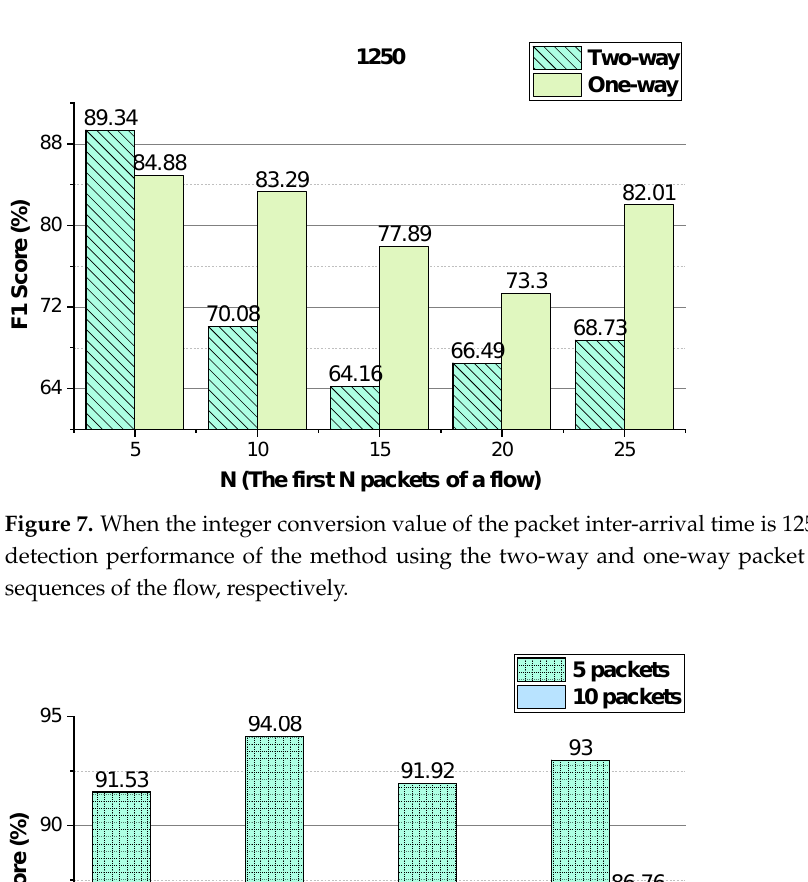
Figure 6. The VPN traffic detection performance of the method using the two-way and one-way packet size sequences of the flow, respectively.